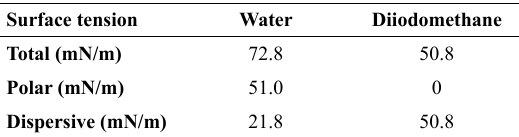
Table 2. Surface tension components for distilled water and